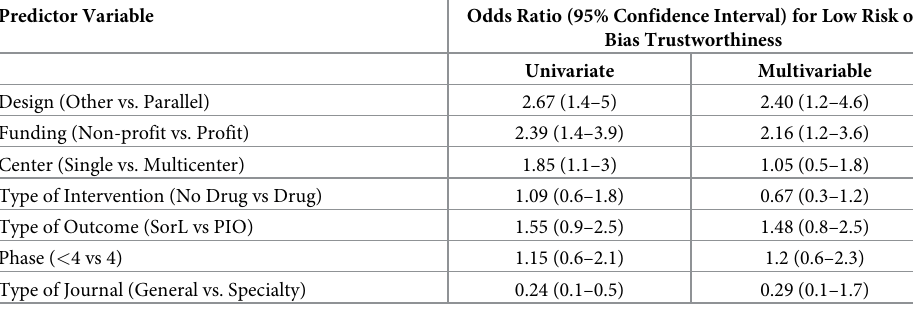
Table 3. Predictor variables for trustworthy